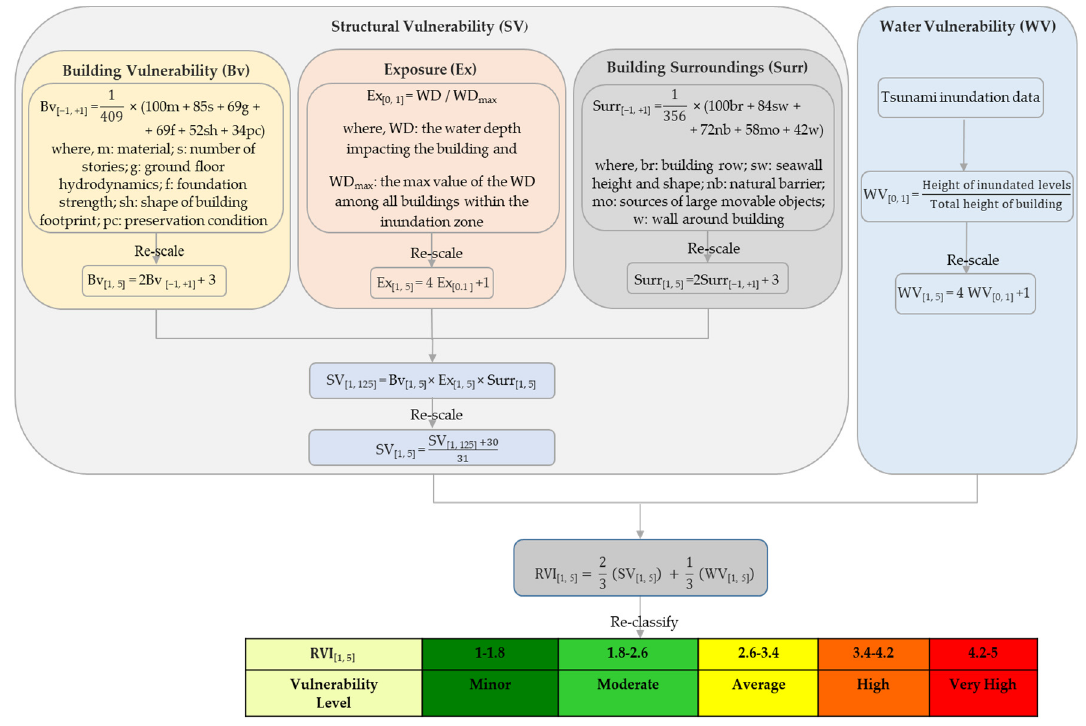
Figure 5. The PTVA-4 model framework.